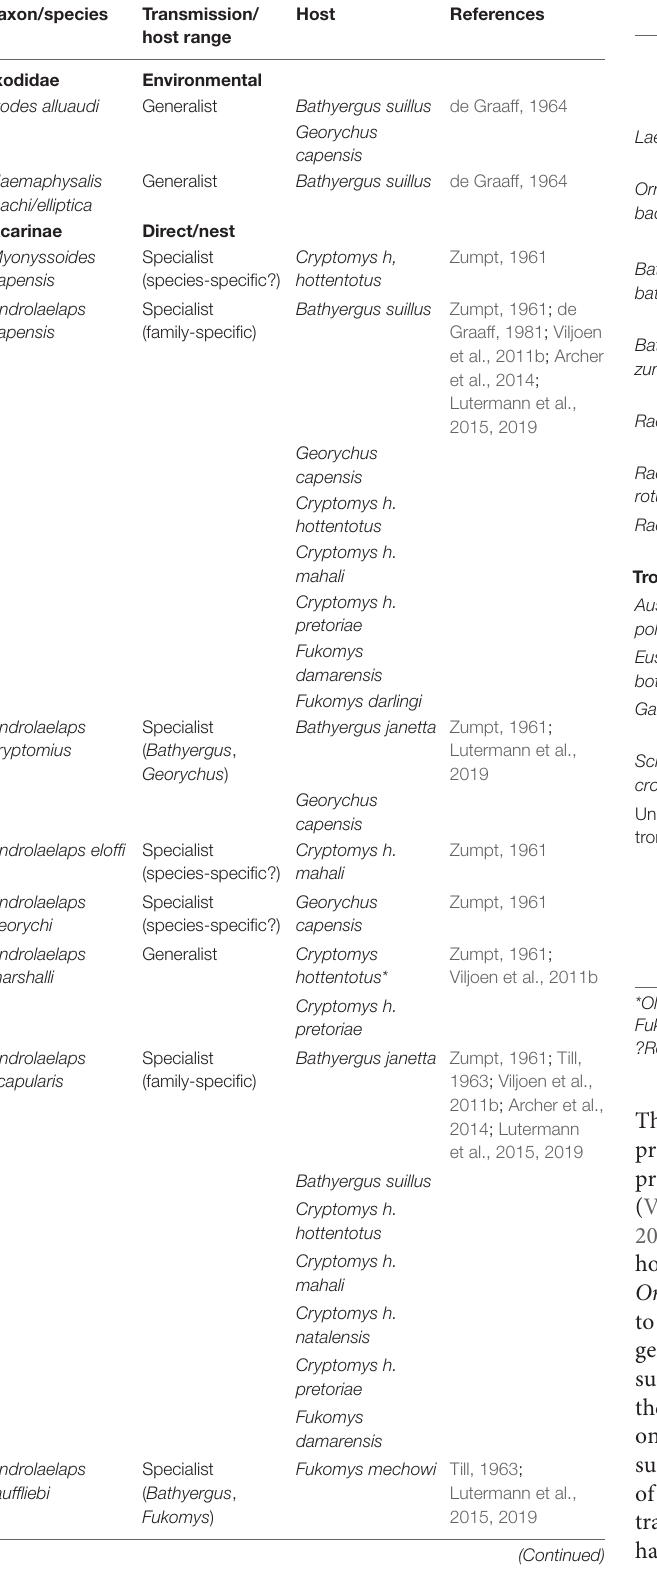
TABLE 2 | Overview of acari parasite species, their mode of transmission and host range reported for the family Bathyergidae to date.